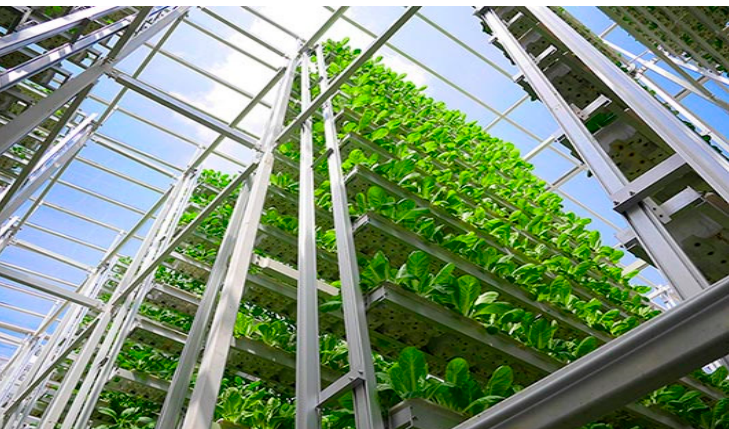
Figure 4. Diagram of skygreen vertical farming technology in Singapore. Reprinted with permission from ref. [29]. Copyright 2021 International Journal of Engineering and Techniques.